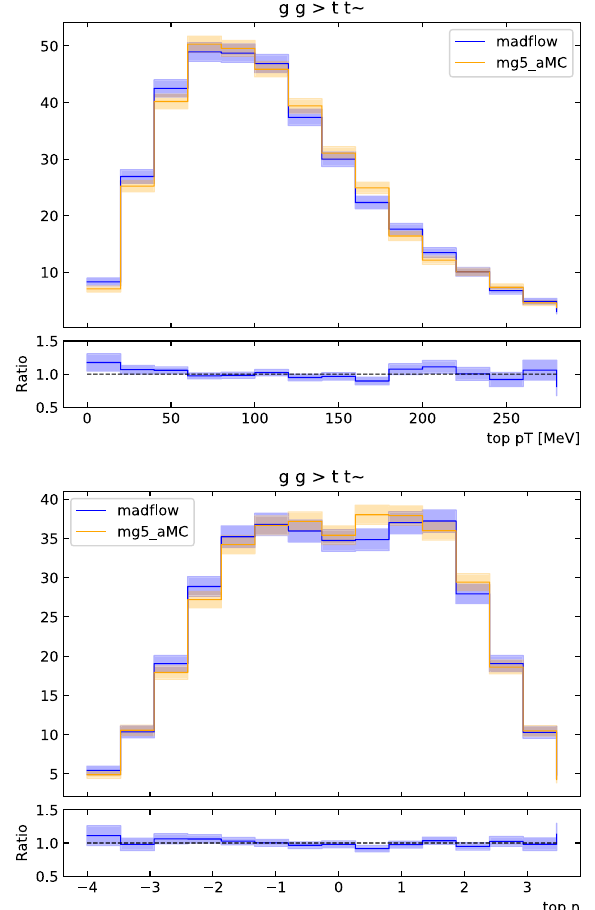
Fig. 2 Leading Order cross section differential on p t , top (first row) and √ η → t ¯ t at s = 13TeV.Wecomparepredictions top (secondrow)for gg between MadFlow (blue) and MG5_aMC (orange). We observe that in both cases the distributions are in statistical agreement